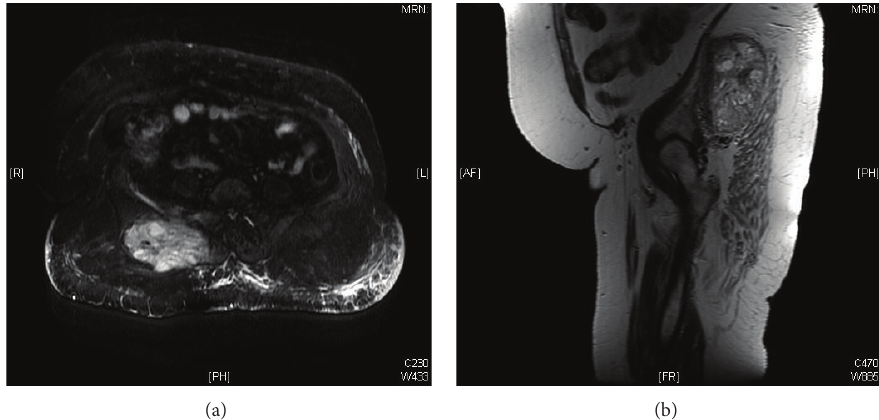
Figure 1: Magnetic resonance imaging (MRI) of the pelvis showing 13 × 11.7 × 6.8 cm lobulated heterogeneous mass in the right gluteus medius muscle also involving the right gluteus maximus, piriformis muscles extending to the right iliac bone and the right sacroiliac joint.